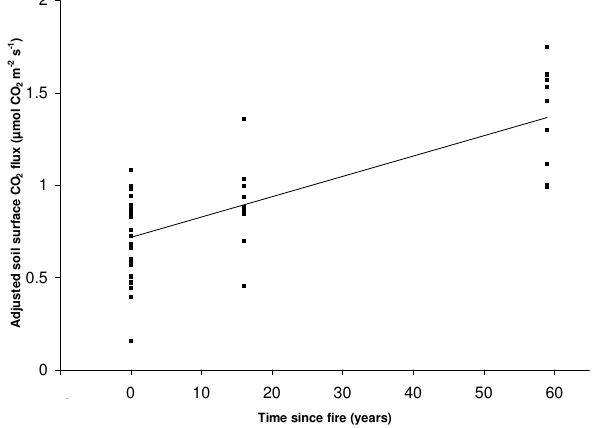
Fig. 3. Adjusted soil surface CO 2 flux versus time since fire at Sharpsand Creek. Individual data points represent (Sect. 2.4–2.5) assuming Q 10 = 2 (dimensionless) and reference soil temperature = 10 ◦ C. Regression equation: y = 0.011x + 0.7168; r 2 =